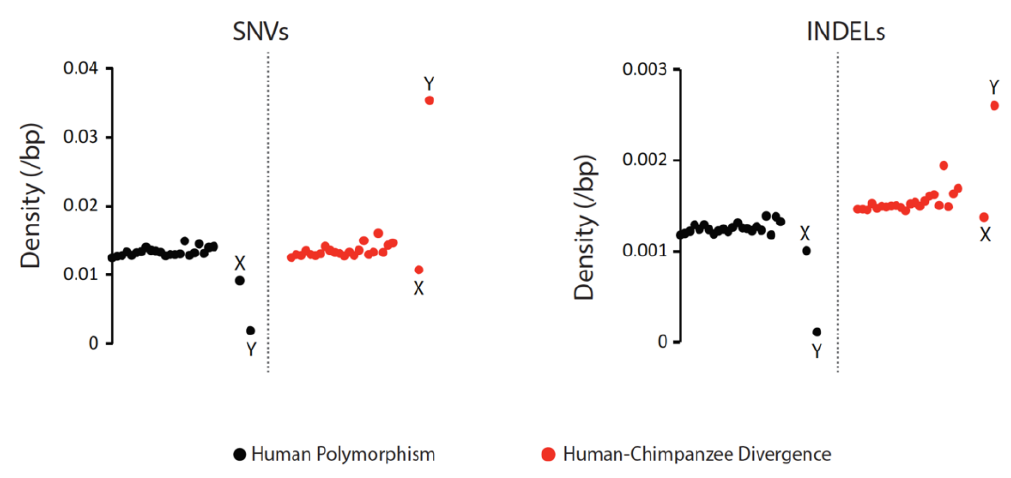
Figure 1 - Density of SNVs and indels in X, Y and Autosomes. The density was computed as the number of mutations per bp of the “accessible chromosome” (for segregating polymorphisms) or of